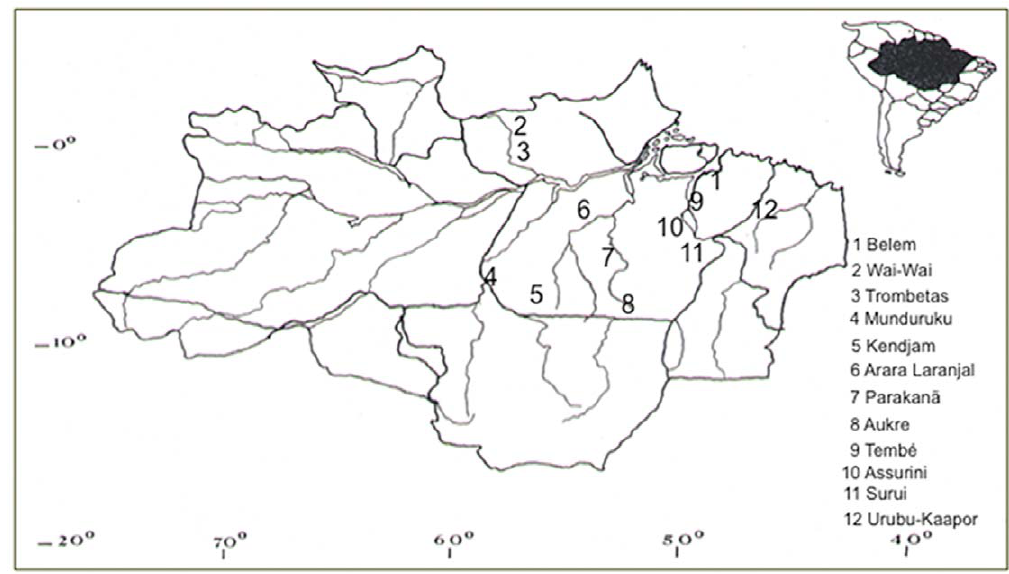
Figure 1. Geographical location of urban and non-urban populations investigated in the present study.